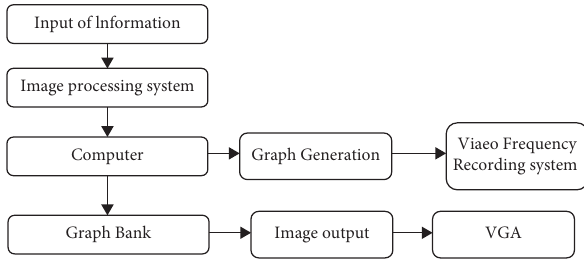
Figure 2: System composition and